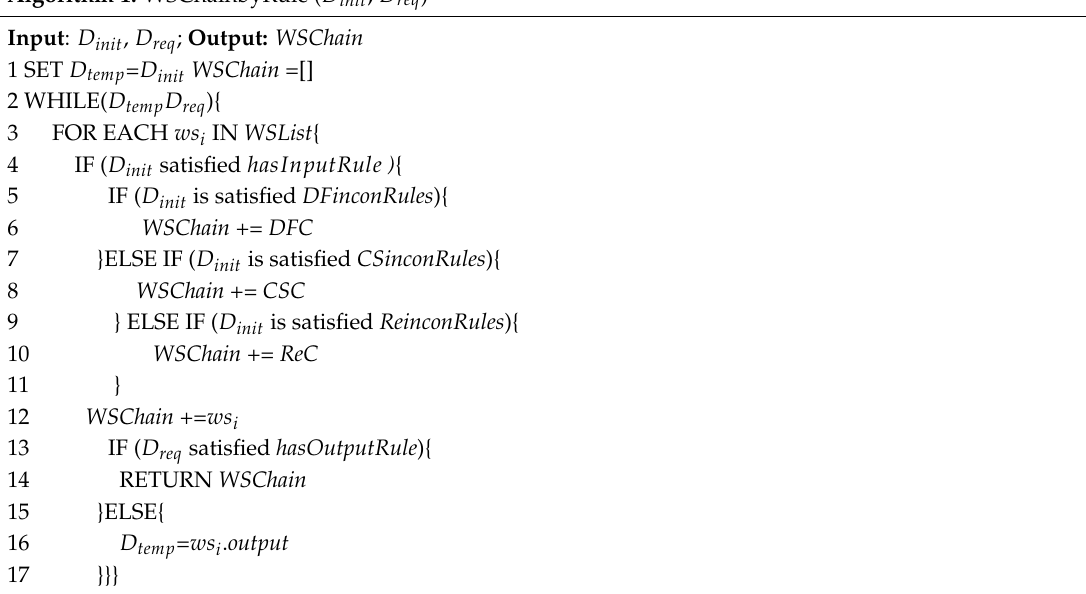
Algorithm 1. WSChainbyRule ( D init , D req